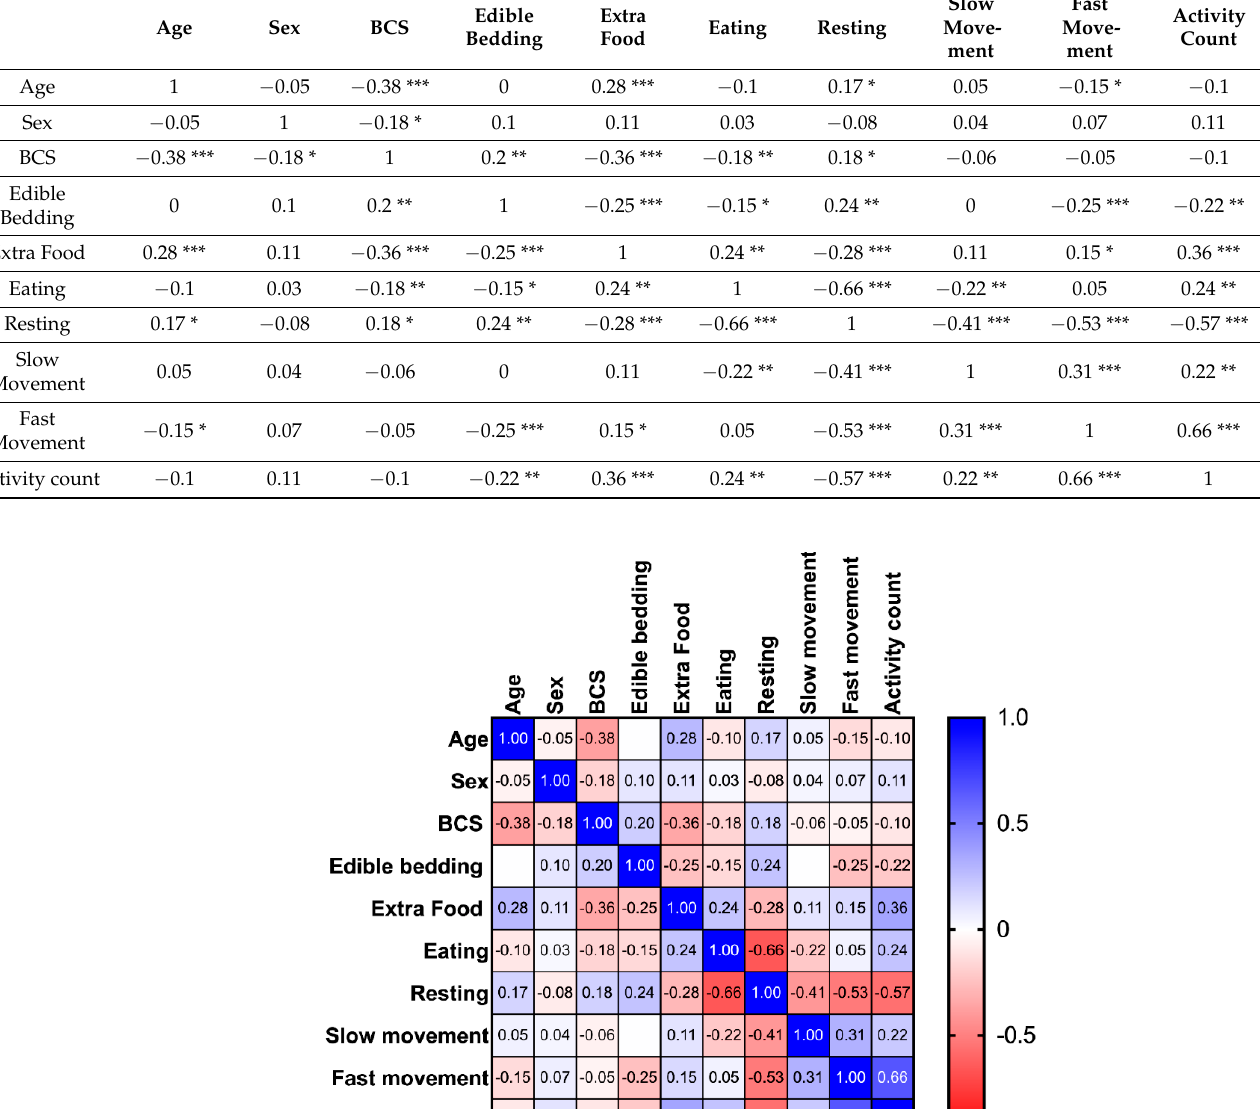
Table 5. The correlation coefficients (r) for age, sex, body condition score (BCS), edible bedding, extra food, and the time budgets for eating, resting, active, highly active and the activity counts (bold indicates significance, *** p < 0.001, ** p < 0.01, * p < 0.05).